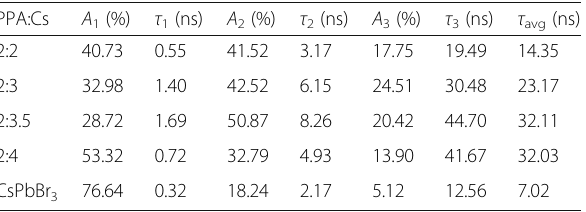
Table 1 Detailed fitted parameters of time-resolved photoluminescence decay curve